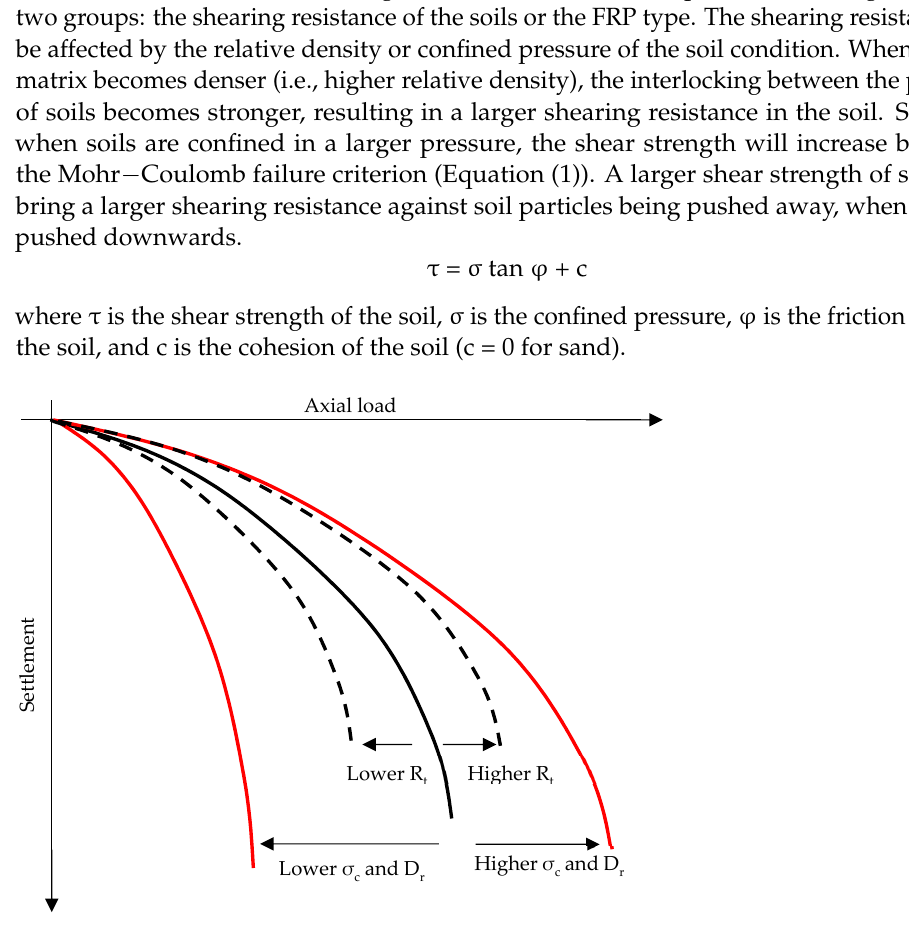
Figure 12. Crack on the tension side of the GFRP pile after aging in pH = 12.